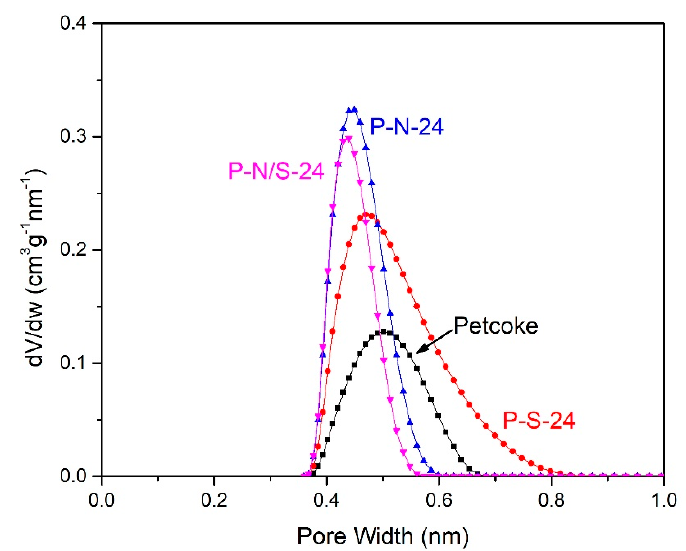
Figure 3. Pore size distributions of petcoke before and after various acid treatments, as determined by CO 2 adsorption using a 2D-NLDFT-HS model.